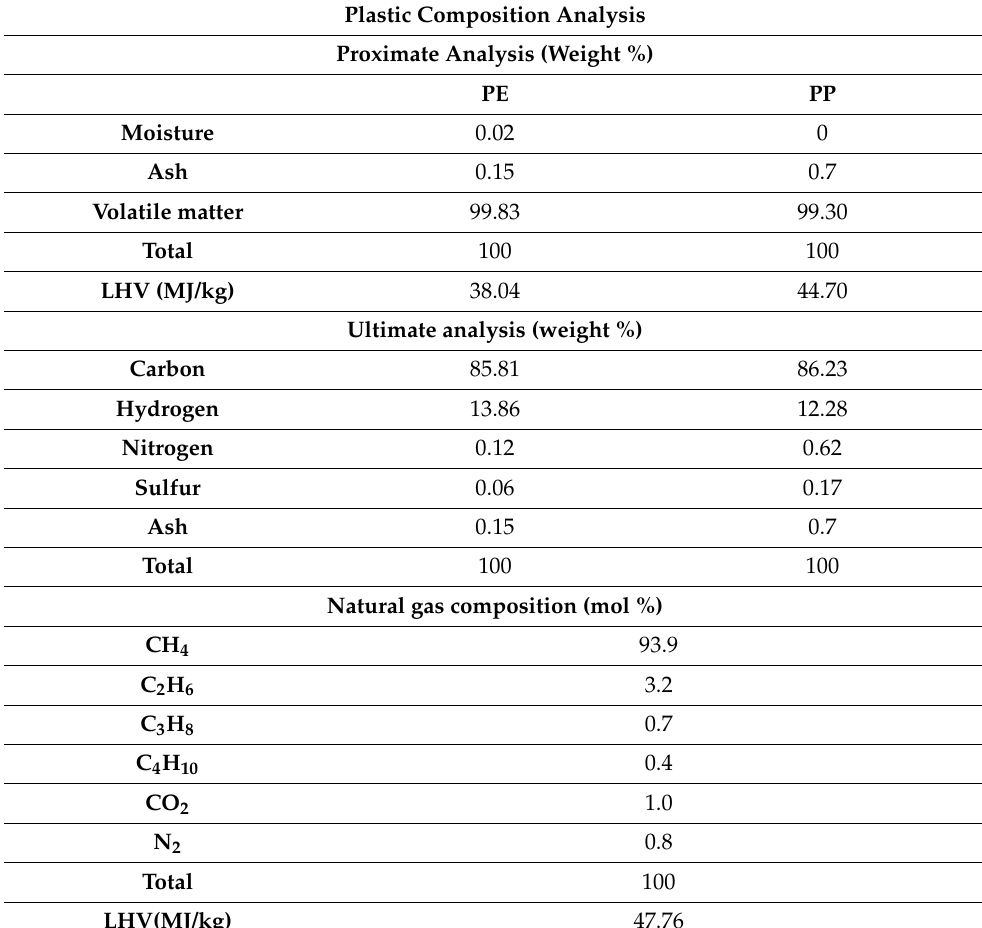
Table 1. Plastics and natural gas composition.